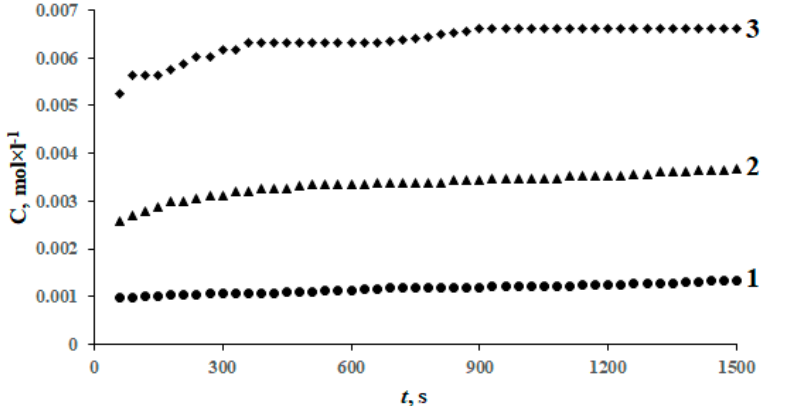
Figure 1. Kinetic curves of methylene blue polymerization at the following temperatures: 1–298 K; 2–308 K; 3–318 K (methylene blue concentration 5 × 10 − 3 mol × L − 1 ; concentration of ammonium peroxodisulfate 0.02 mol × L − 1 ).